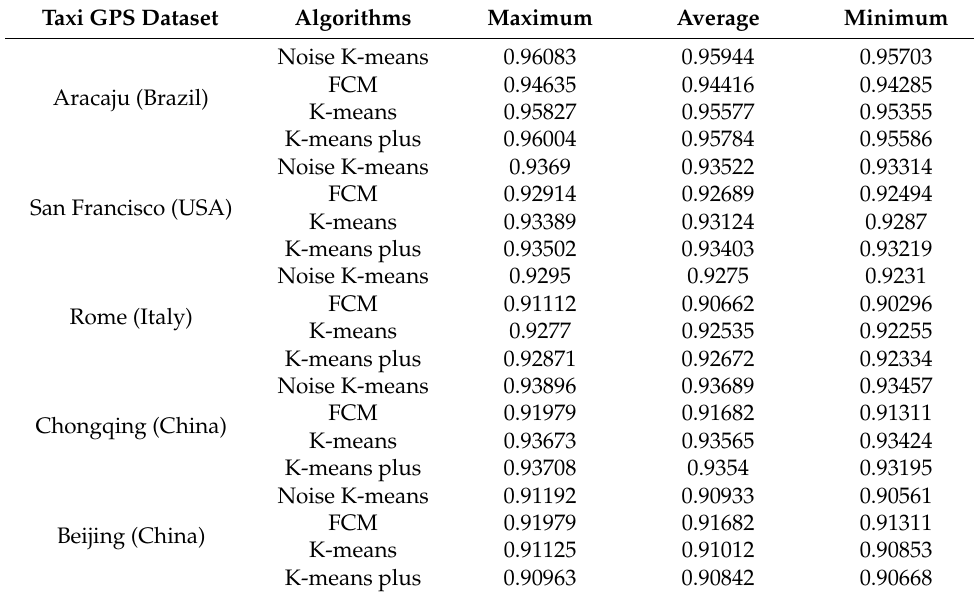
Table 3. Comparison results of SC evaluation